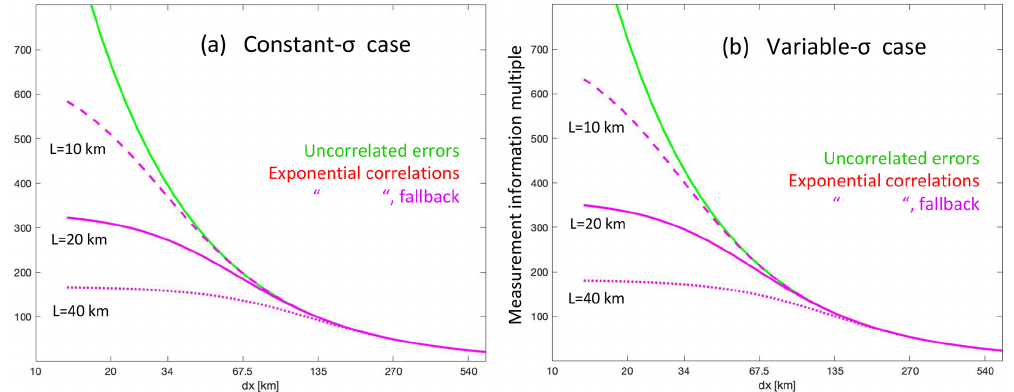
Figure 3. The measurement information content across 13358km, or 1 / 3 of an orbit (the typical daylit portion across which data is taken), given as σ − 2 avg /σ − 2 o as a function of the distance (cid:49)x spanned by each averaging interval for (a) the constant- σ and (b) the variable- σ cases. The number of averaging spans, J , is given by (13358km) /(cid:49)x . If all averaging spans are assumed to have independent errors (green line), the information ratio equals J ; i.e., the information is simply summed up. When the exponential correlation model is assumed (magenta lines), the total information is reduced; how much it is reduced depends on the correlation length assumed: 10km (dashed), 20km (solid), or 40km (dotted). For these longer (cid:49)x values, both assumptions for the weighting of the data going into the average for the correlation length model give the same results to the eye on this